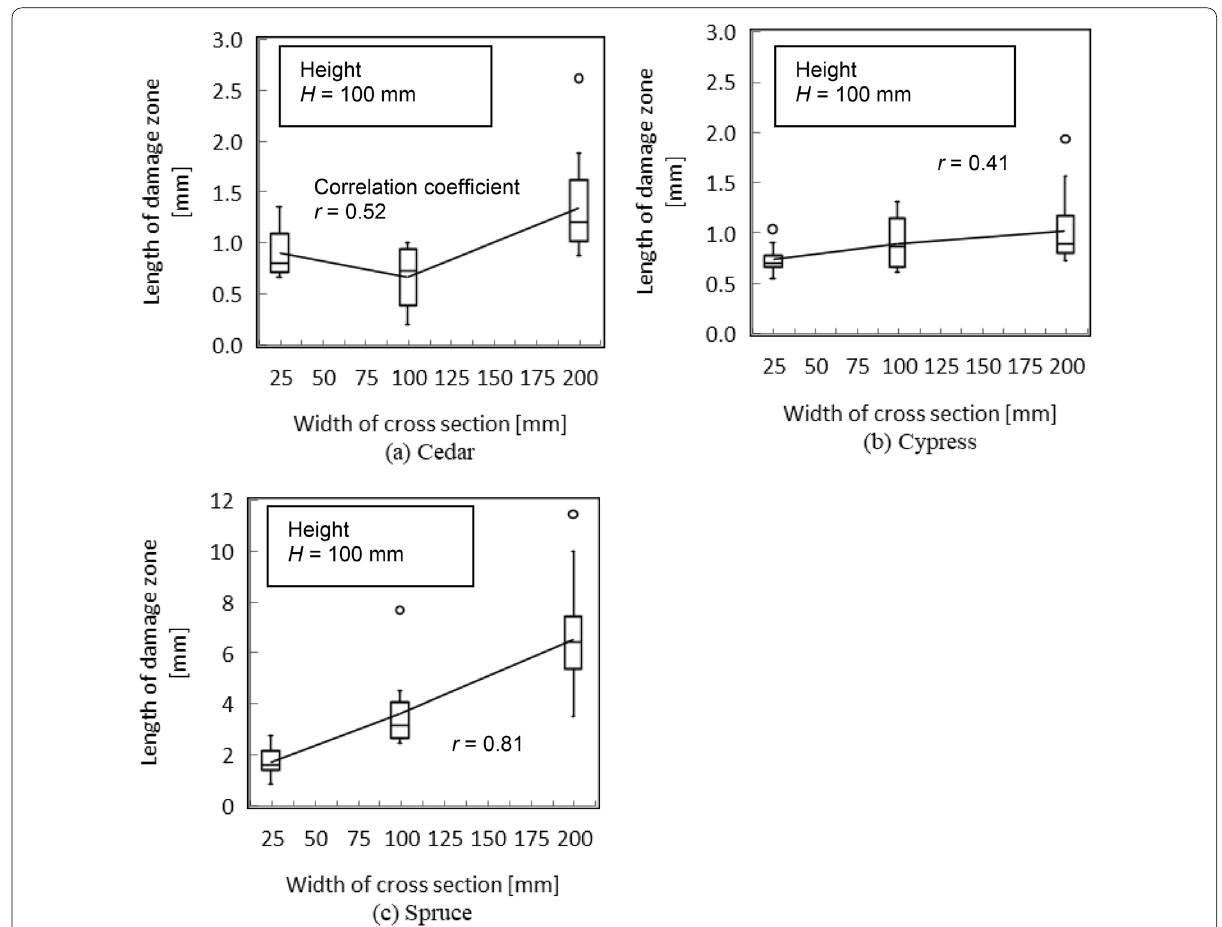
Fig. 11 Length of damage zone of specimens of varying widths of